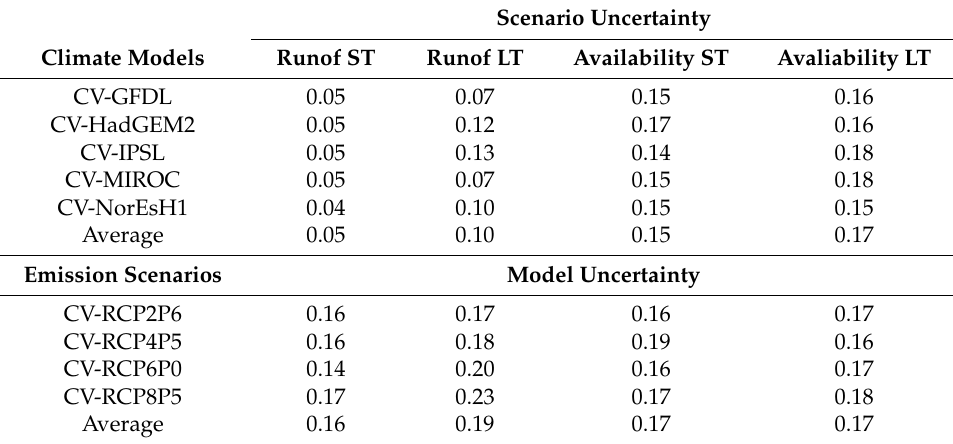
Table 1. Summary of the emissions scenarios’ and climate models’ uncertainty for the 50% probability of exceeding CV